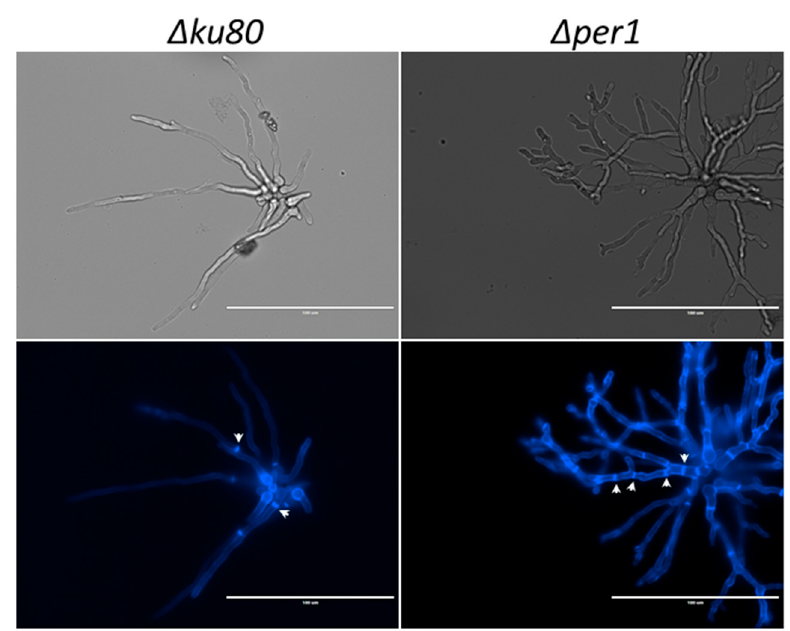
Figure 3. Morphology of the Δ per1 mutant. Microscopic observation of mycelium after 10–13 h at 37 °C in liquid minimum medium. Both bright-field (upper panels) and fluorescence after calcofluor white staining (lower panels) images are shown. Arrows indicate septum location.